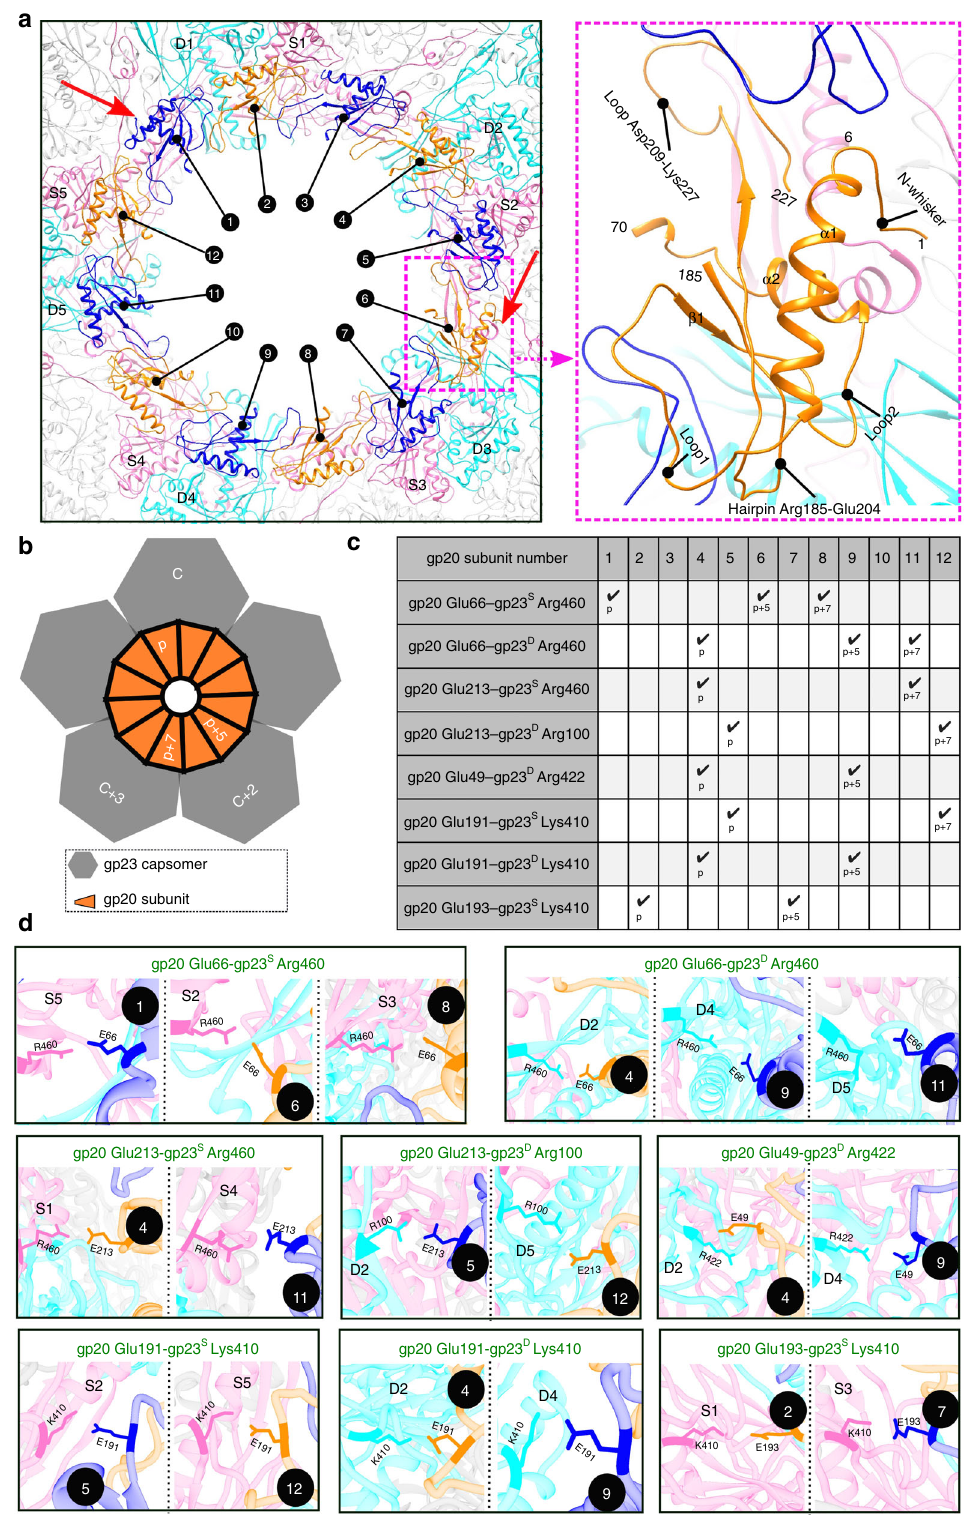
Fig. 2 Portal-capsid interactions in the symmetry-mismatched vertex. a Arrangement of the portal and capsid subunits in the in situ structure. The gp20 subunits and gp23* subunits are colored and labeled as in Fig. 1a (S and D gp23* subunits in magenta and cyan, respectively, and alternative gp20 subunits in blue and orange). For clarity, only the N-terminal 70 residues, loop Asp209-Lys227, and hairpin Arg185-Glu204 of each gp20 subunit that make contacts with the capsid are shown and one of the subunits is enlarged. The two potential methionine-metal clusters are indicated by red arrows. b Schematic diagram showing the symmetry mismatch between the portal assembly and the capsid. c , d Charge interactions between the portal and its surrounding gp23* capsomers showing a morphing relationship between p, p + 5, and p + 7 portal subunits to compensate for the symmetry